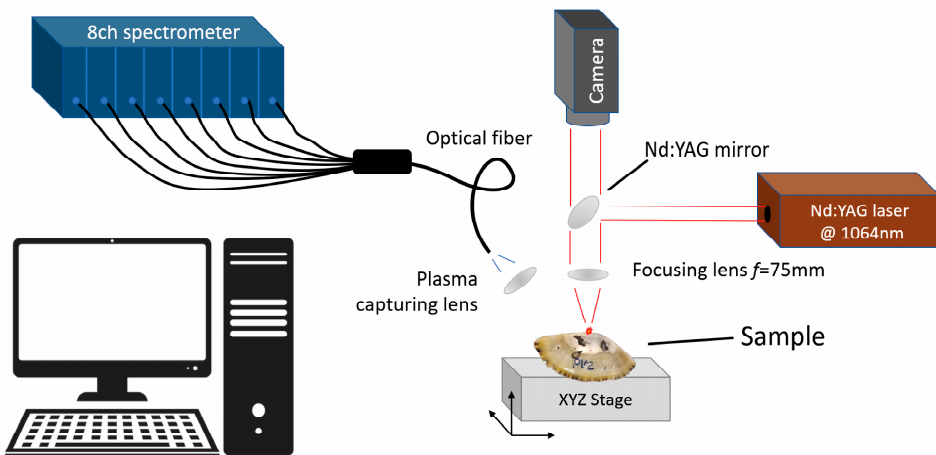
Figure 2. Laser-induced breakdown spectroscopy (LIBS)